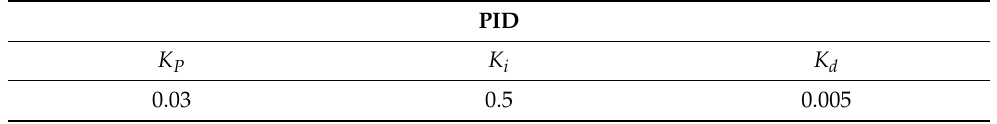
Table 7. The controller parameters of the PID